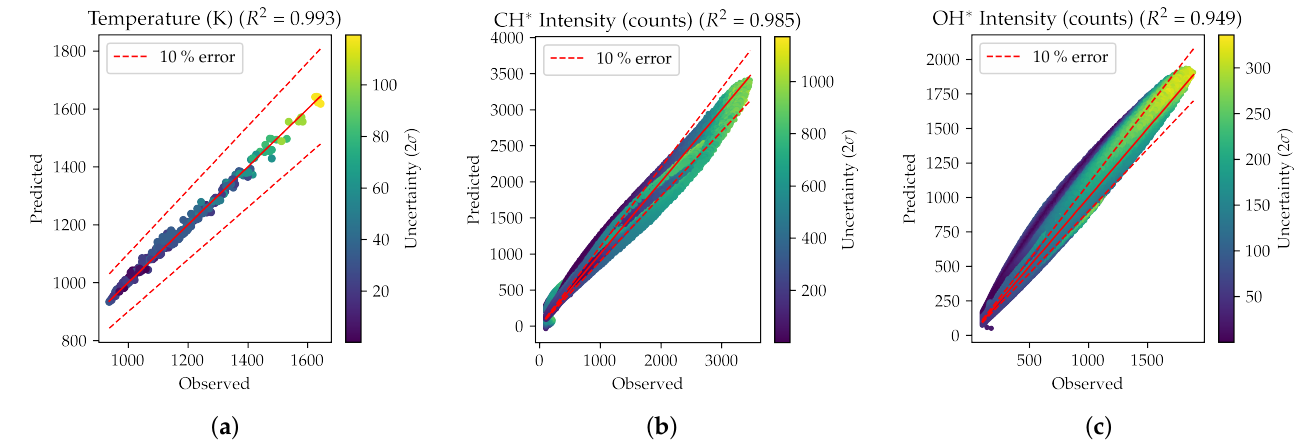
Figure 6. Parity plot for the temperature ( a ); CH ∗ signal ( b ); and OH ∗ signal ( c ), for the six testing cases. The uncertainty represents the model’s uncertainty in the prediction. The R 2 for the OH ∗ and CH ∗ signals has been calculated by excluding the points with a count lower than 100.